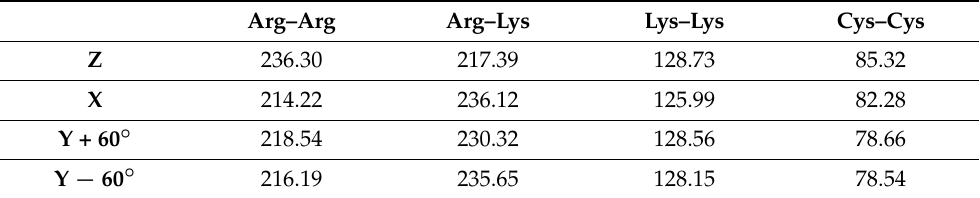
Figure 8. Fraction of elastic energy of prismatic and basal crystal faces of D114C crystals as a function of the cross ‐ linker and penetration depth. To compare the influence of protein engineering on the mechanical behavior of CLECs, wild ‐ type (WT) CLECs, adapted from ref. [22]. Table 4. Summary of the direction ‐ dependent crystal strength of D114C crystals modeled using the anisotropic intermolecular cross ‐ linking bonds.